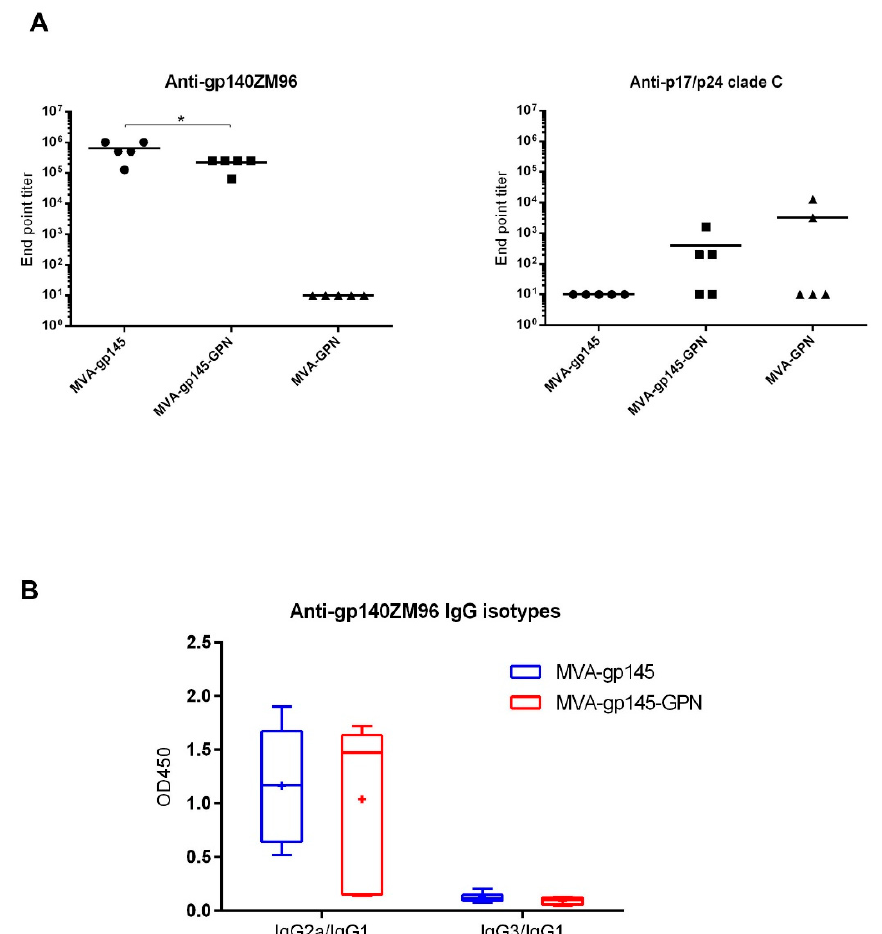
Figure 6. HIV-1-specific humoral immune response elicited in serum after prime/boost homologous immunization of mice with different MVA-based recombinant viruses expressing gp145 and/or GPN antigens. ( A ) Levels of anti-gp140- (left panel) or anti-p17/p24- (right panel) specific total IgG binding antibodies measured in individual sera from immunized mice at 10 days post-boost by ELISA. End point titer is defined as the last serum dilution that gave three times the mean OD 450 value of the control group. The solid line represents the mean value of each group. *, p < 0.05. ( B ) Anti-gp140 IgG2a/IgG1 or IgG3/IgG1 ratios elicited in serum from immunized individual mice at 10 days post-boost measured as OD 450 at a serum dilution of 1:64000 by ELISA. The “+” symbol indicates the mean value of each group; the box shows the 5th to 95th percentiles and the line in the box indicates the median value of each group.